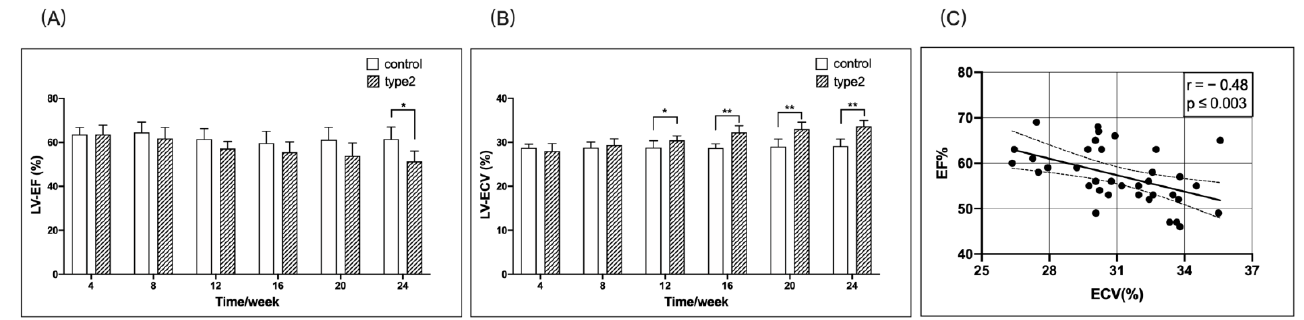
Figure 3. Timely/weekly comparison of the LV-EF and LV-ECV between the T2DM mice and controls, and the correlation between the EF and ECV. The mean LV-EF in the T2DM mice was decreased starting at 8 weeks, but reached significant difference (* p < 0.05) at 24 weeks when compared to the matched control mice ( A ). The mean LV-ECV was significantly higher (** p < 0.01) in the T2DM mice than that in the matched control mice from 12 – 24 weeks ( B ). There was a significant correlation between LV-EF and LV-ECV ( C ). EF, ejection fraction; ECV, extracellular volume.